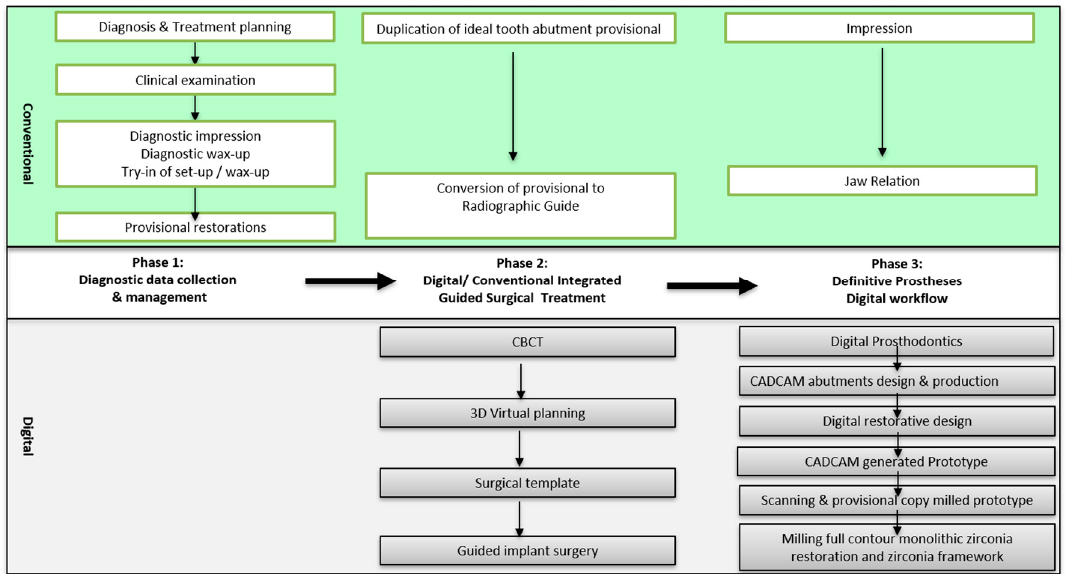
Figure 9. Overall workflow of integrated digital and conventional protocol applied to full mouth implant-supported fixed rehabilitation.